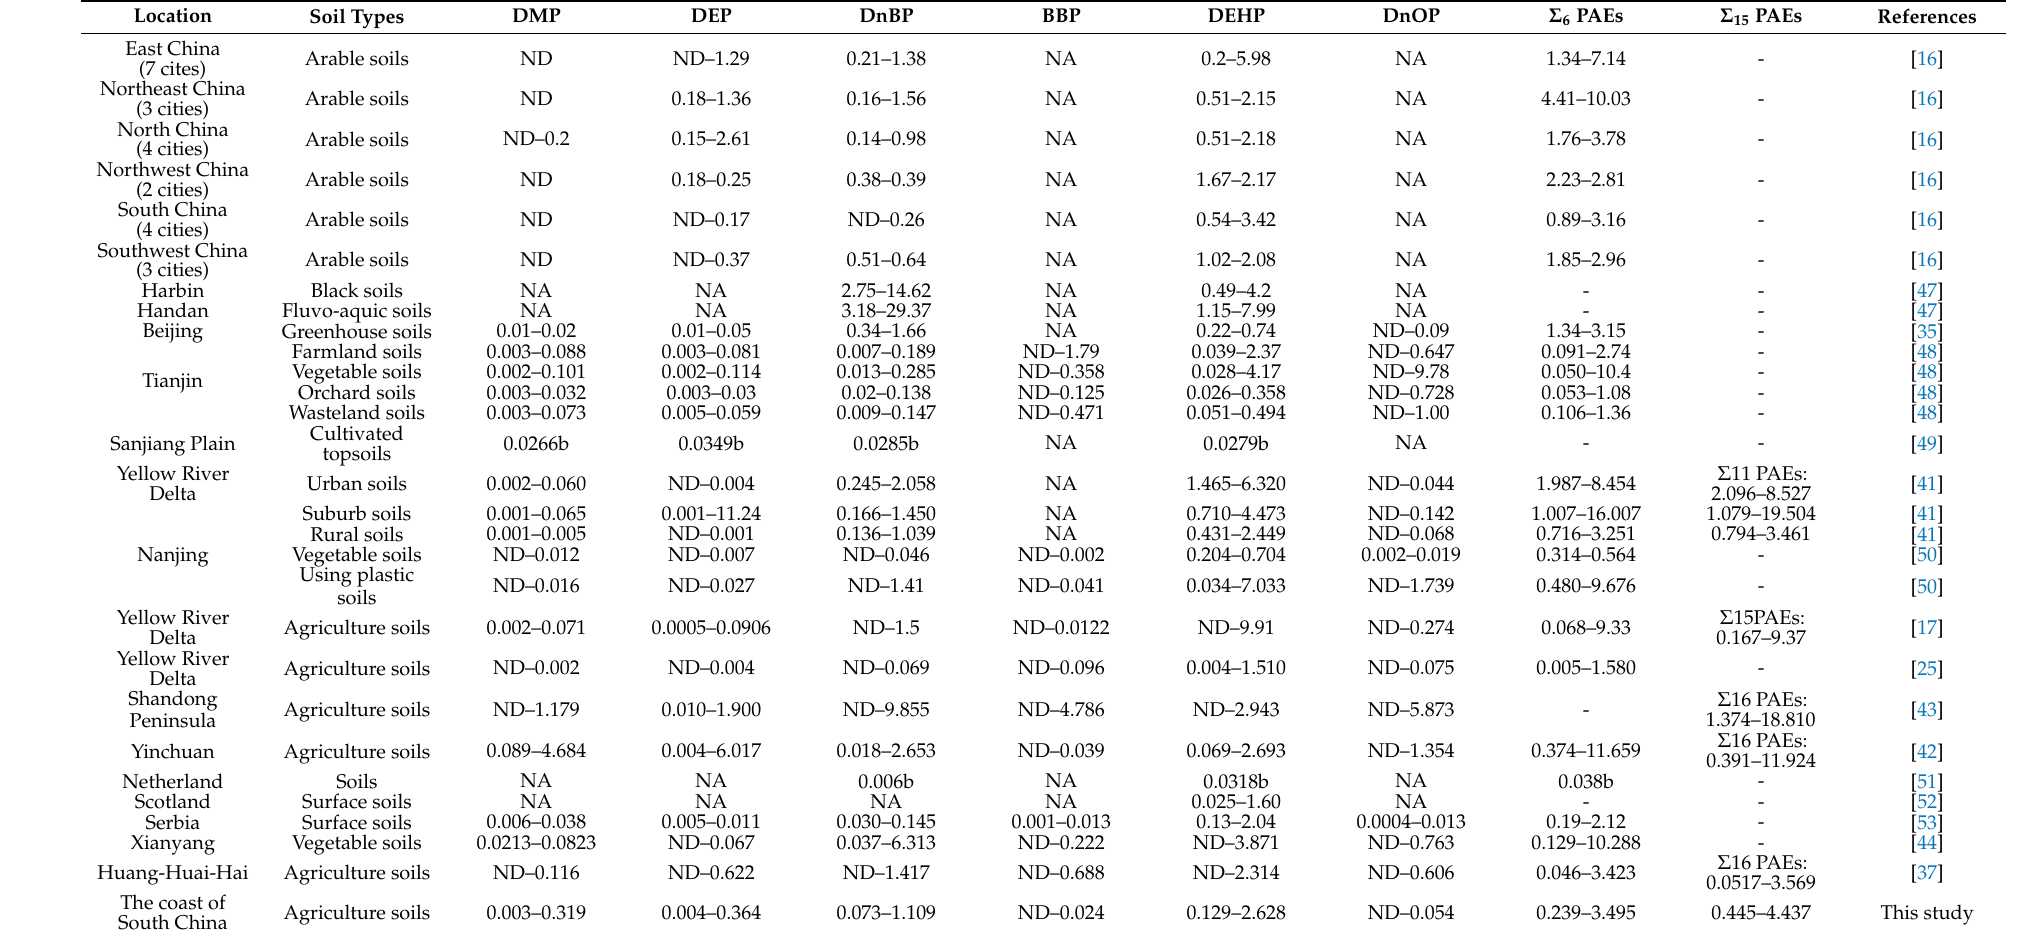
Table 2. Comparison of concentration of PAEs in the soil of different regions (mg/kg, dry